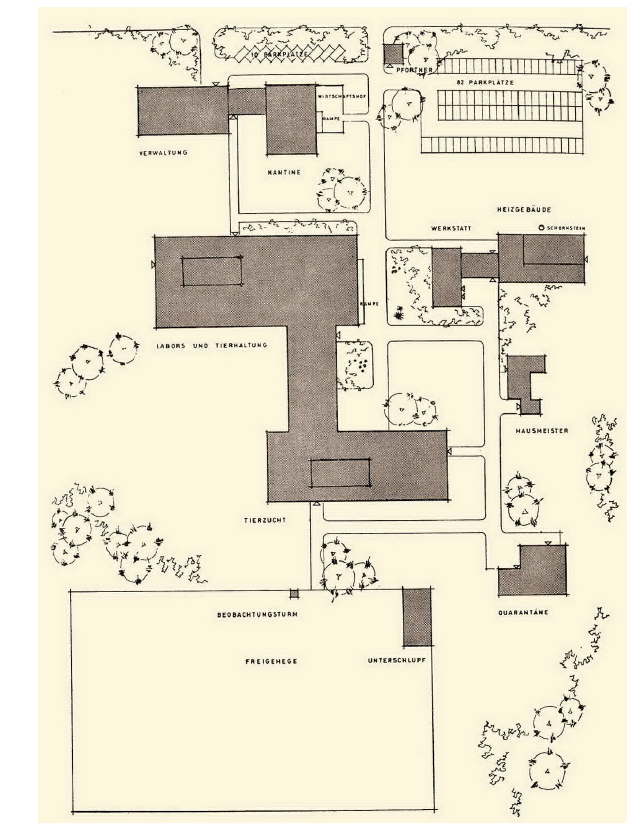
Figure 6. Construction design for the German Primate Center from the memorandum of 1970. It formed the basis for all further plans (picture from DPZ archive).